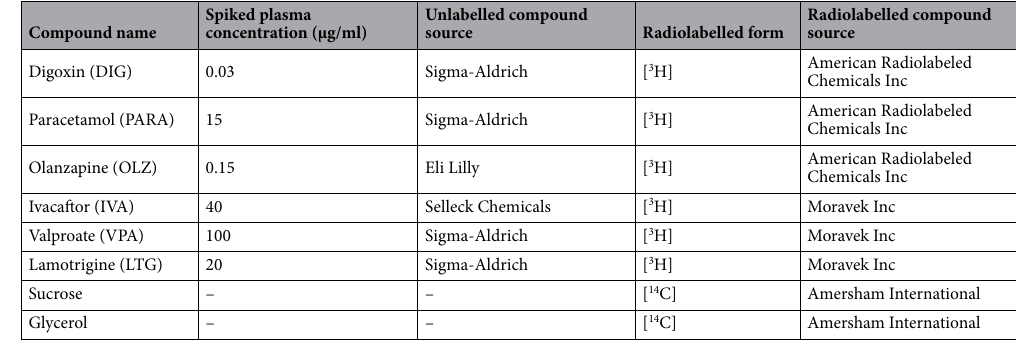
Table 1. Source, label and concentrations of drugs used. Concentrations of drugs used were based on previous in vivo studies (digoxin and paracetamol 35 ; ivacaftor 36 ; valproate and lamotrigine 37 ; olanzapine, Huang et al. 2023 in